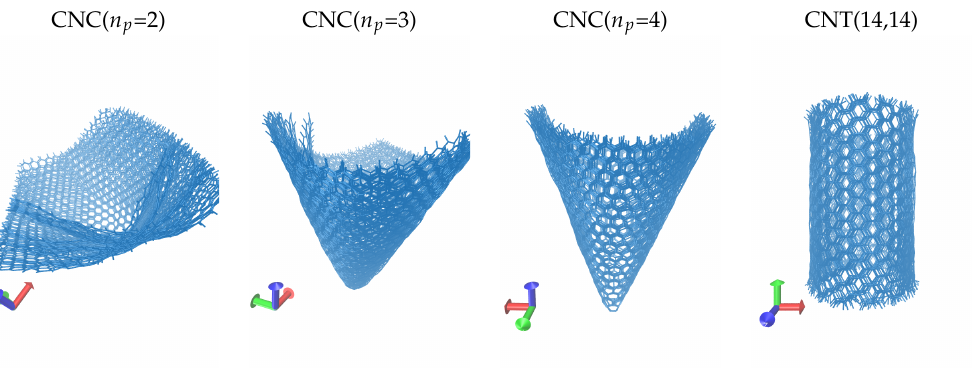
Figure 2. Multiple time frame configurations of CNT(14,14) and of carbon nanocones (CNCs) with different number of pentagons, n p , at the tip. We draw 10 time frame configurations with an interval of 10 ps.